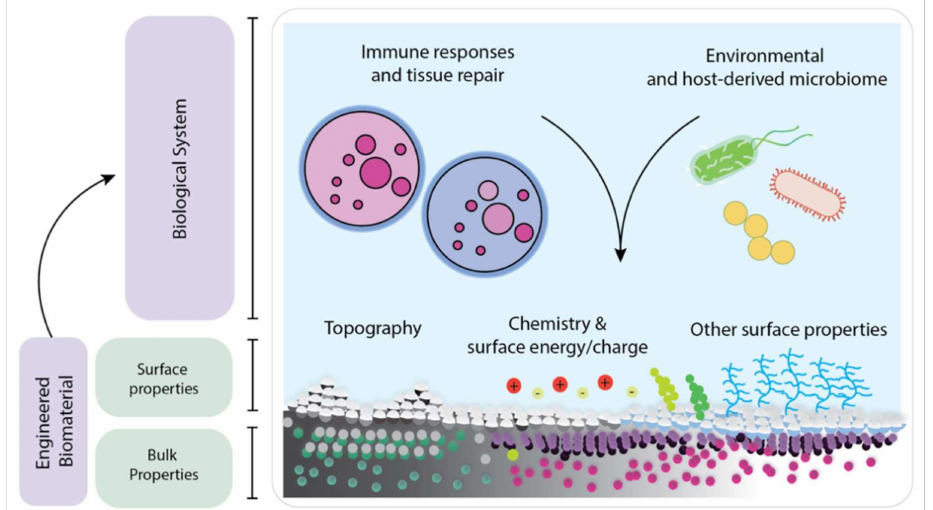
Figure 4. Schematic showing the ideal biomaterial as a combination of engineered bulk and surface properties that trigger adequate immune responses while minimizing the risk of infection, commonly referred as “the race for the